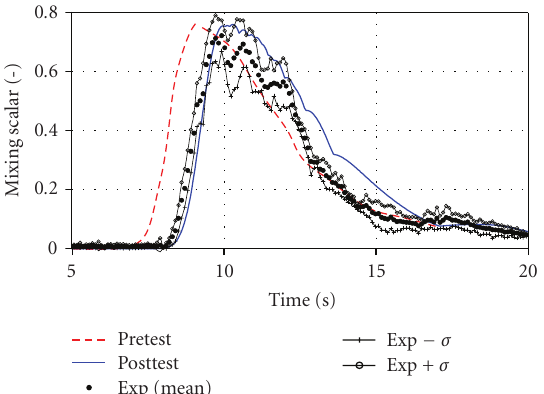
Figure 10: Accumulated perturbation at core inlet.